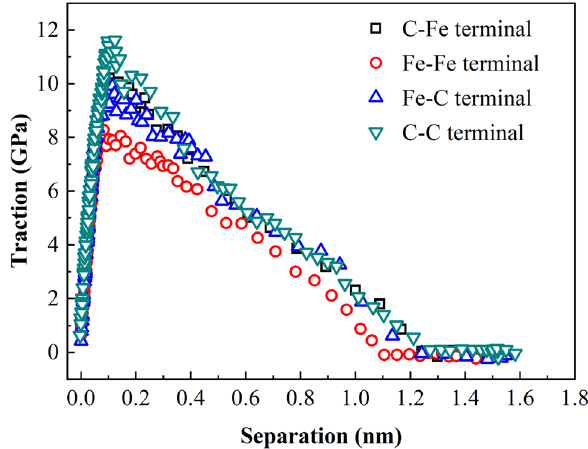
Figure 15. TS curve of four terminal models.